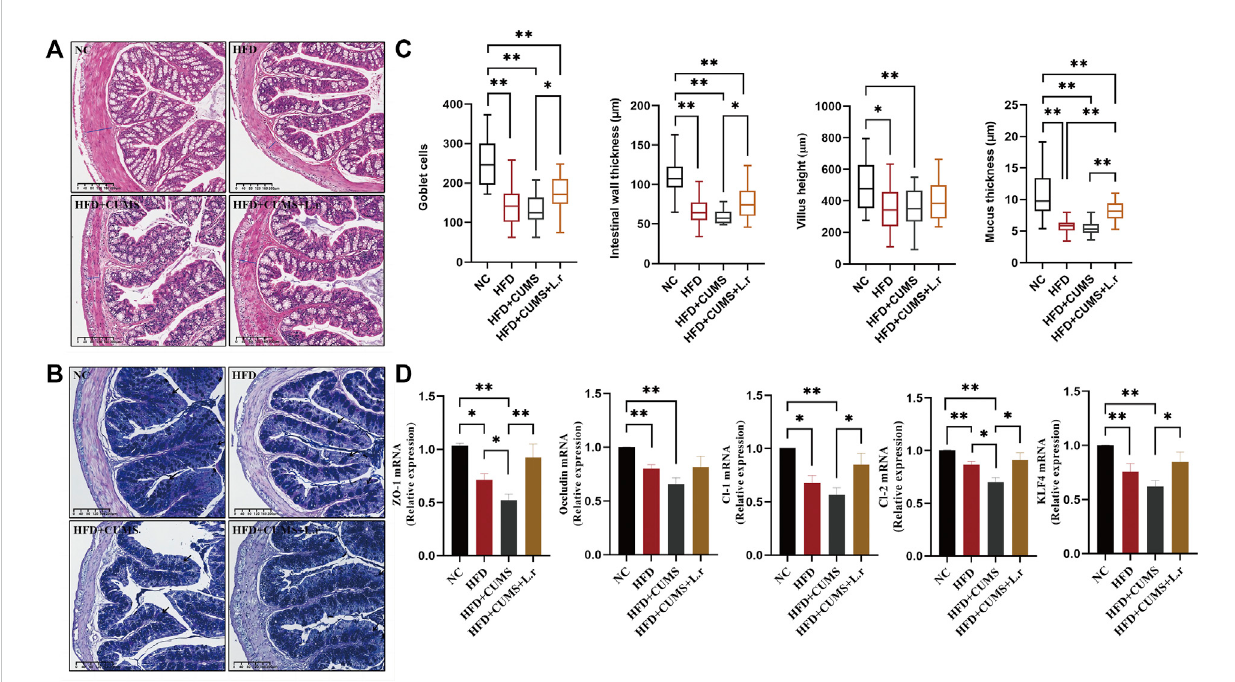
FIGURE 7 Gavagewith Lactobacillusreuteri improvedintestinaltightjunctions( n =8 – 9/group). (A) H&Estainingofthecolontissues. (B) AB-PASstainingofthe colon tissues. (C) Number of goblet cells, intestinal wall thickness, villus height and intestinal mucus thickness of the colon tissues. (D) mRNA expression levels of ZO-1, Occludin, Claudin-1, Claudin-2, and KLF4 in the colon tissues. Data are shown as the mean ± SEM. * p < 0.05, ** p < 0.01 (Statistical comparisons between the two groups were performed using the two independent samples t -test. Comparisons between multiple groups were performed using One-way ANOVA and Tukey